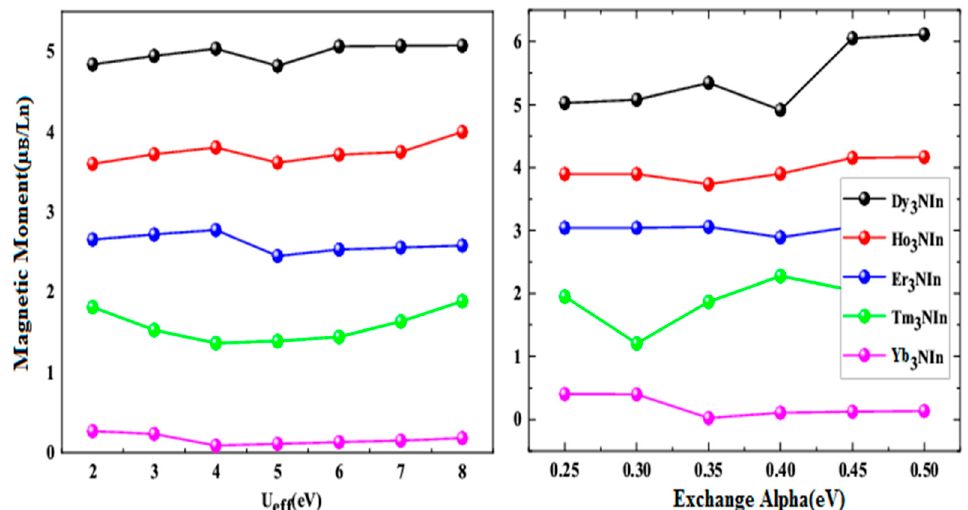
Figure 1. ( a ) optimization of Hubbard U, ( b ) exchange alpha against magnetic moment of Ln atom